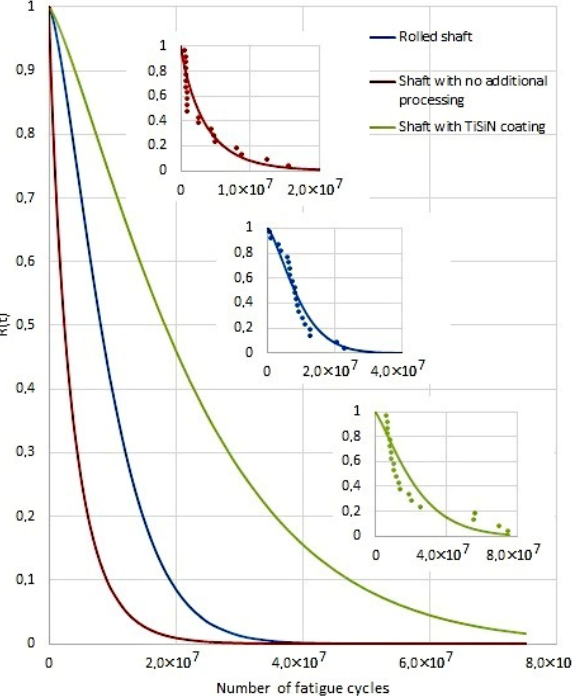
Figure 7. Reliability function.